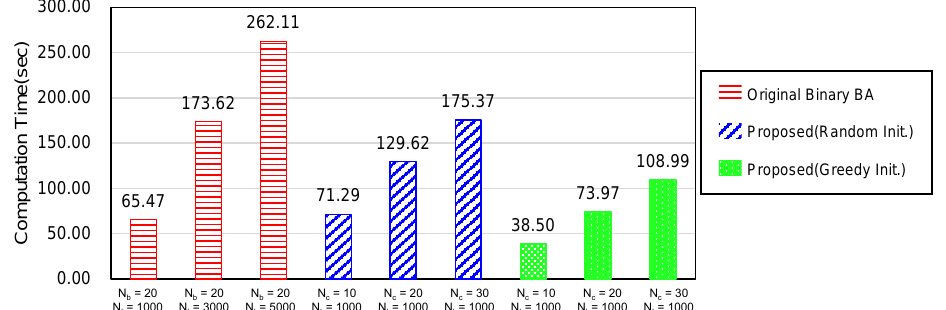
Figure 9. Average computation time according to the versions of Binary Bat Algorithm.